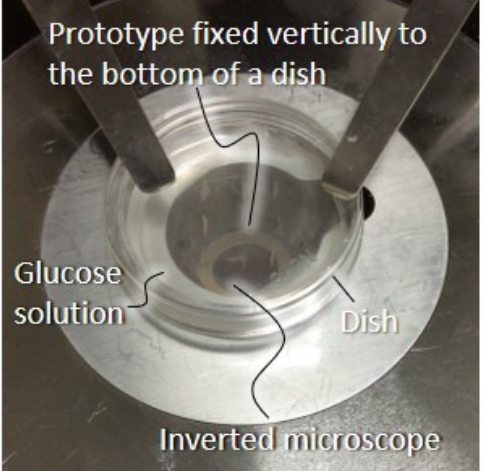
Figure 7. Experimental setup to observe flows around a prototype in glucose solution (67 mM β -D- glucose, 150 mM NaCl, and polystyrene (PS) beads with the size of 3 and 7 µ m in 10 mM phosphate buffered saline, pH 7.4). The prototype was adhesively fixed vertically to the bottom of a